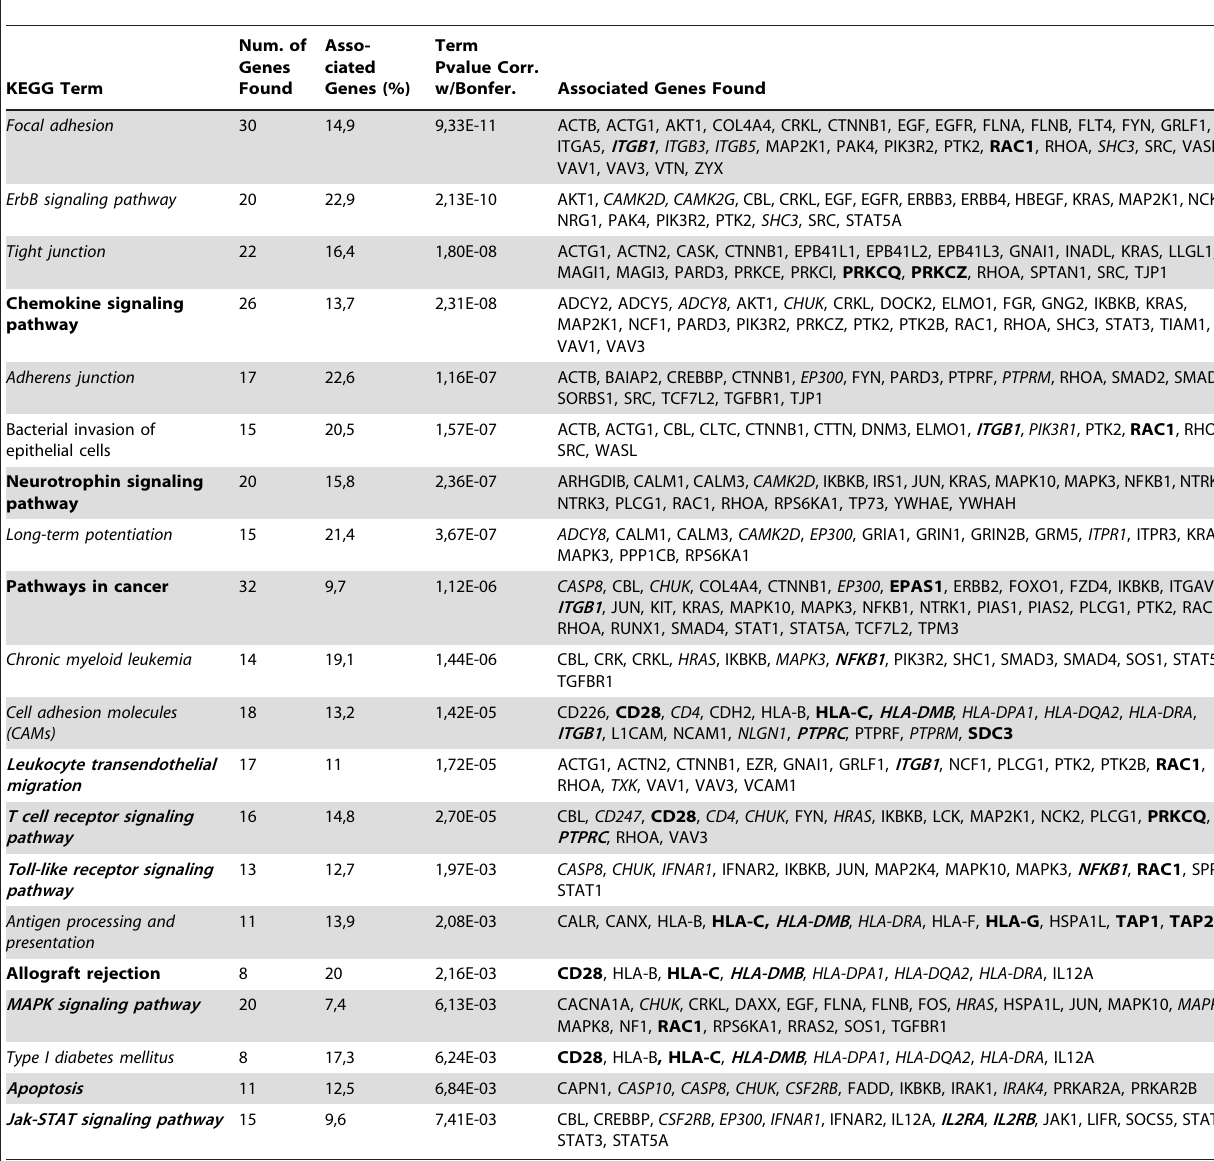
Table 2. Overrepresented KEGG Pathways found in the highest scoring sub-network as associated with